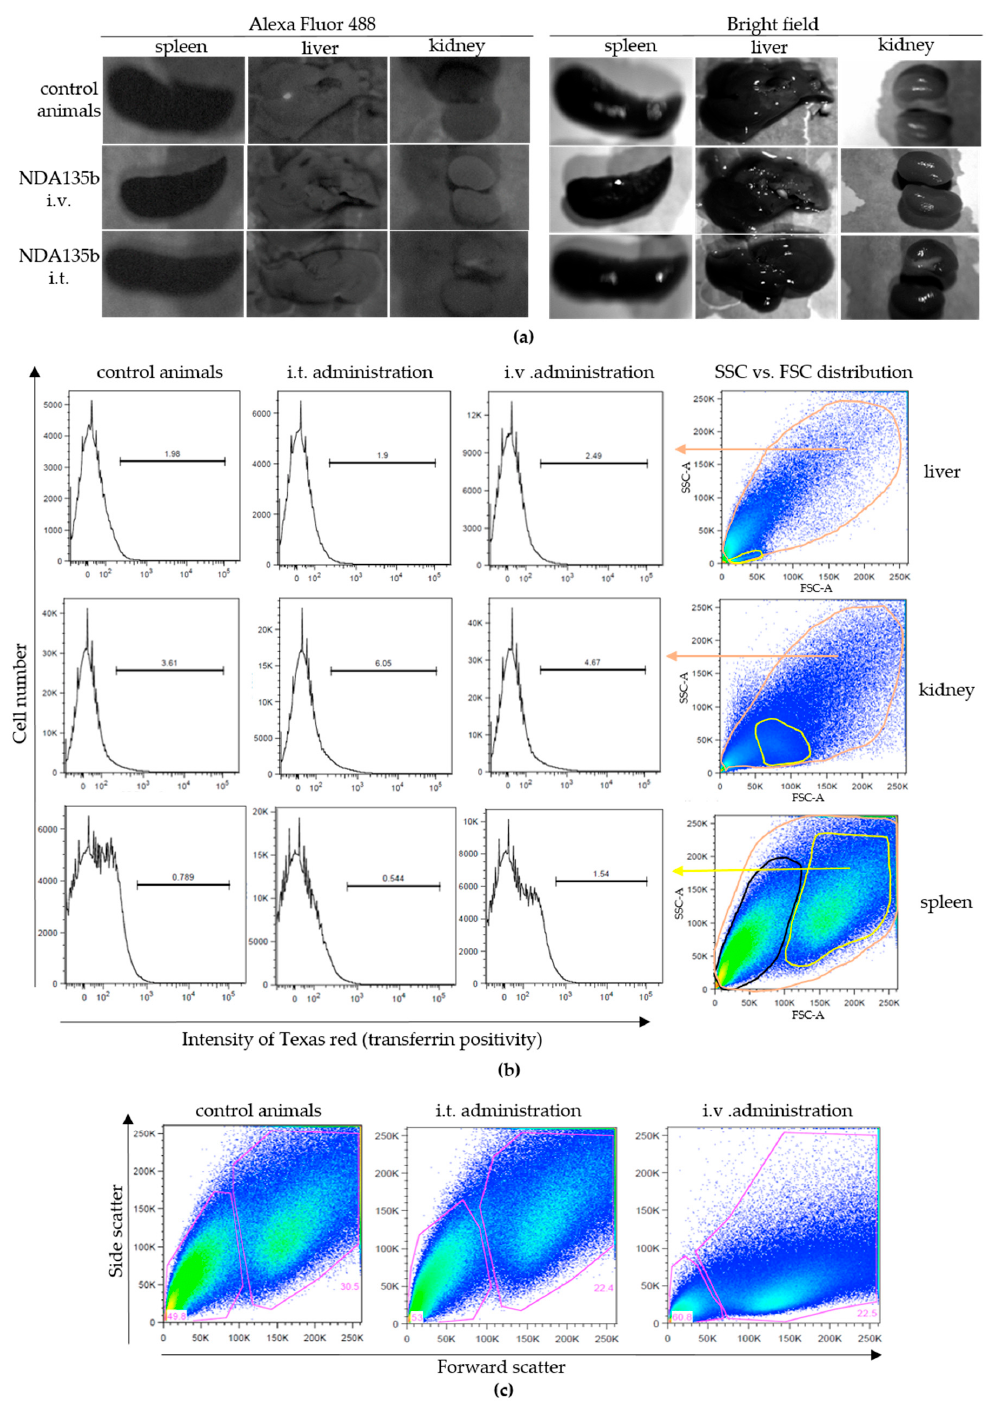
Figure 6. ( a ) Detection of transferrin conjugate in tissues excised from experimental animals administered with NDA135b intravenously or intratumoral: ( a ) Detection of NDA135b complexes in tissues ex vivo by microscopy. Control animals received saline only; ( b ) detection of NDA135b in excised tissues by flow cytometry. Representative dot plots and histograms are shown (exemplary gating is on the right). The histograms of liver and kidney samples consider signal from all cell-like events (orange gate). In spleen, histograms show signal in leukocytes (yellow gate in dot plots); ( c ) comparison of di ff erent splenocytes granularity after NDA135b intravenous and intratumoral